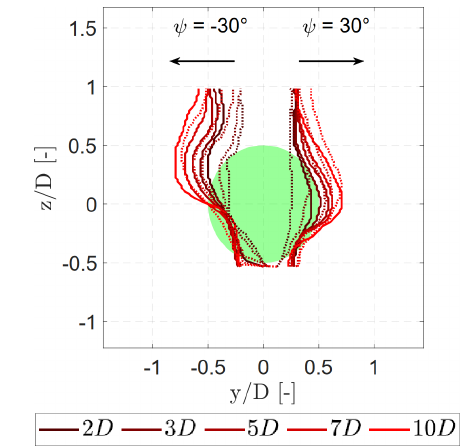
Figure 10. Position of the minimum velocity determined at each z position for each inflow condition. Dotted lines: uniform, passive grid. Solid lines: boundary layer, passive grid.